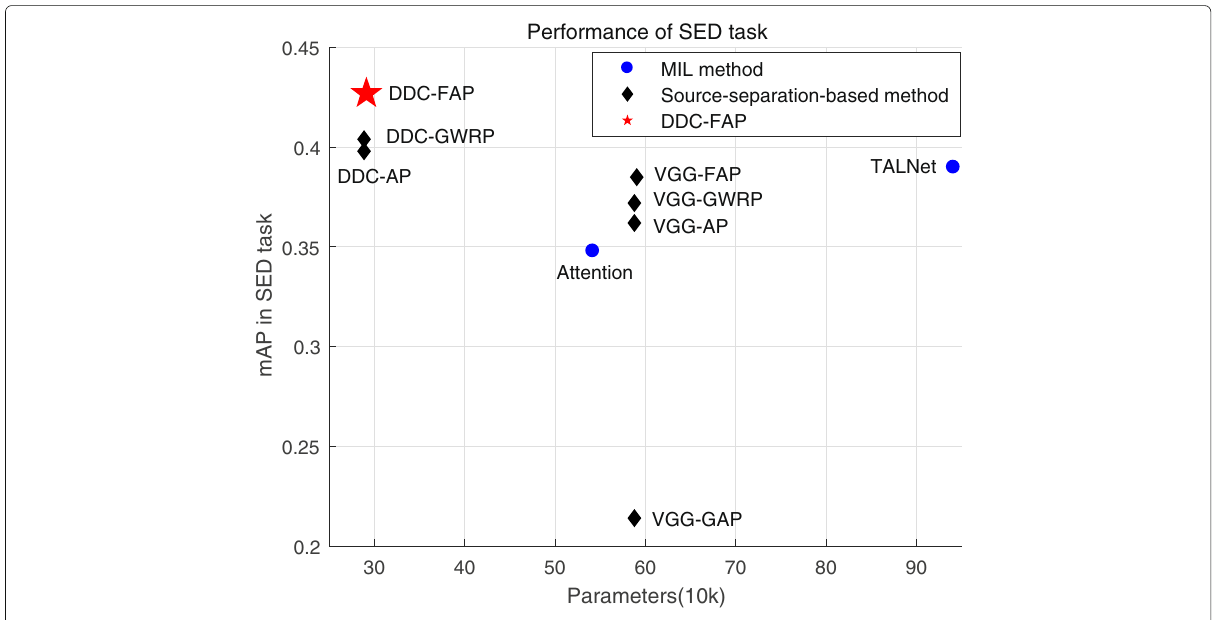
Fig. 6 The number of parameter and performance in the SED task